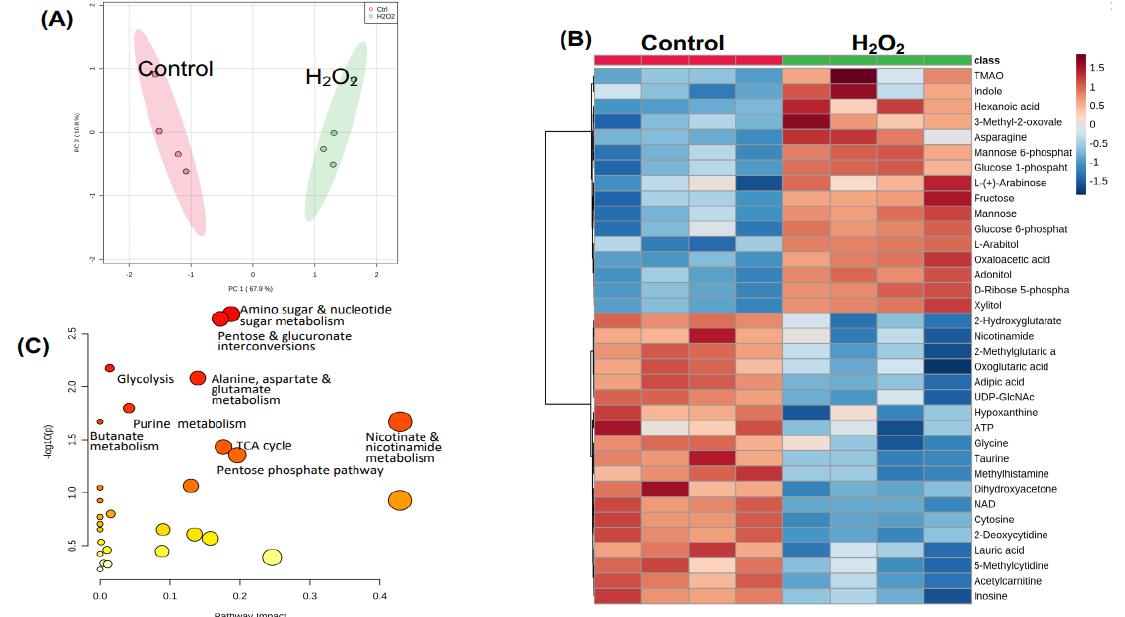
Figure 3. Metabolites and Metabolic Pathways Altered by H 2 O 2 treatment. AC16 human cardiac myocytes were seeded in 6-well plates and cultured in DMEM containing 12.5% FBS. When reaching 90% confluency, cells were serum-starved in 0.5% FBS DMEM/F12 overnight. The cells were treated with 200 μ M of H 2 O 2 for 1 h before extraction of aqueous metabolites by 80% methanol from cell lysates for LC-MS/MS-based metabolomics. The overall metabolic profile differences between ctrl and H 2 O 2 -treated cells are shown by the PCA score plot ( A ). The heatmap shows significant differences (n = 4, p < 0.05) in 35 metabolites between Ctrl and H 2 O 2 -treated cells ( B ). The altered metabolic pathways by H 2 O 2 treatment are displayed with the x -axis representing the pathway impact score computed from pathway topological analysis and the y -axis being -log10 of the p -value obtained from the pathway enrichment analysis ( C ). Metabolic pathway analyses by MetaboAnalyst 5.0 software depict the impact of H 2 O 2 treatment, with the x -axis, y -axis, color, or size of the circle reflecting the information as described in Figure 2C.